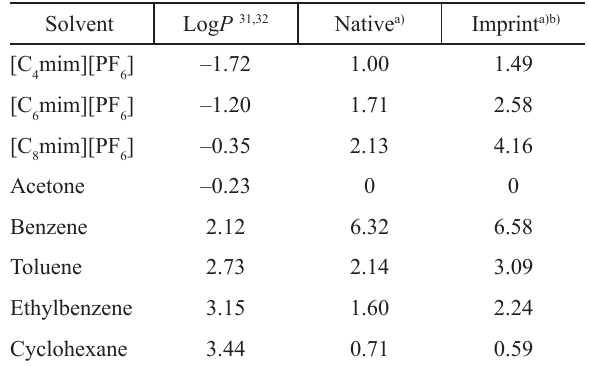
Table 1 – Effect of solvent on transesterification of vinyl ac- etate and benzyl alcohol